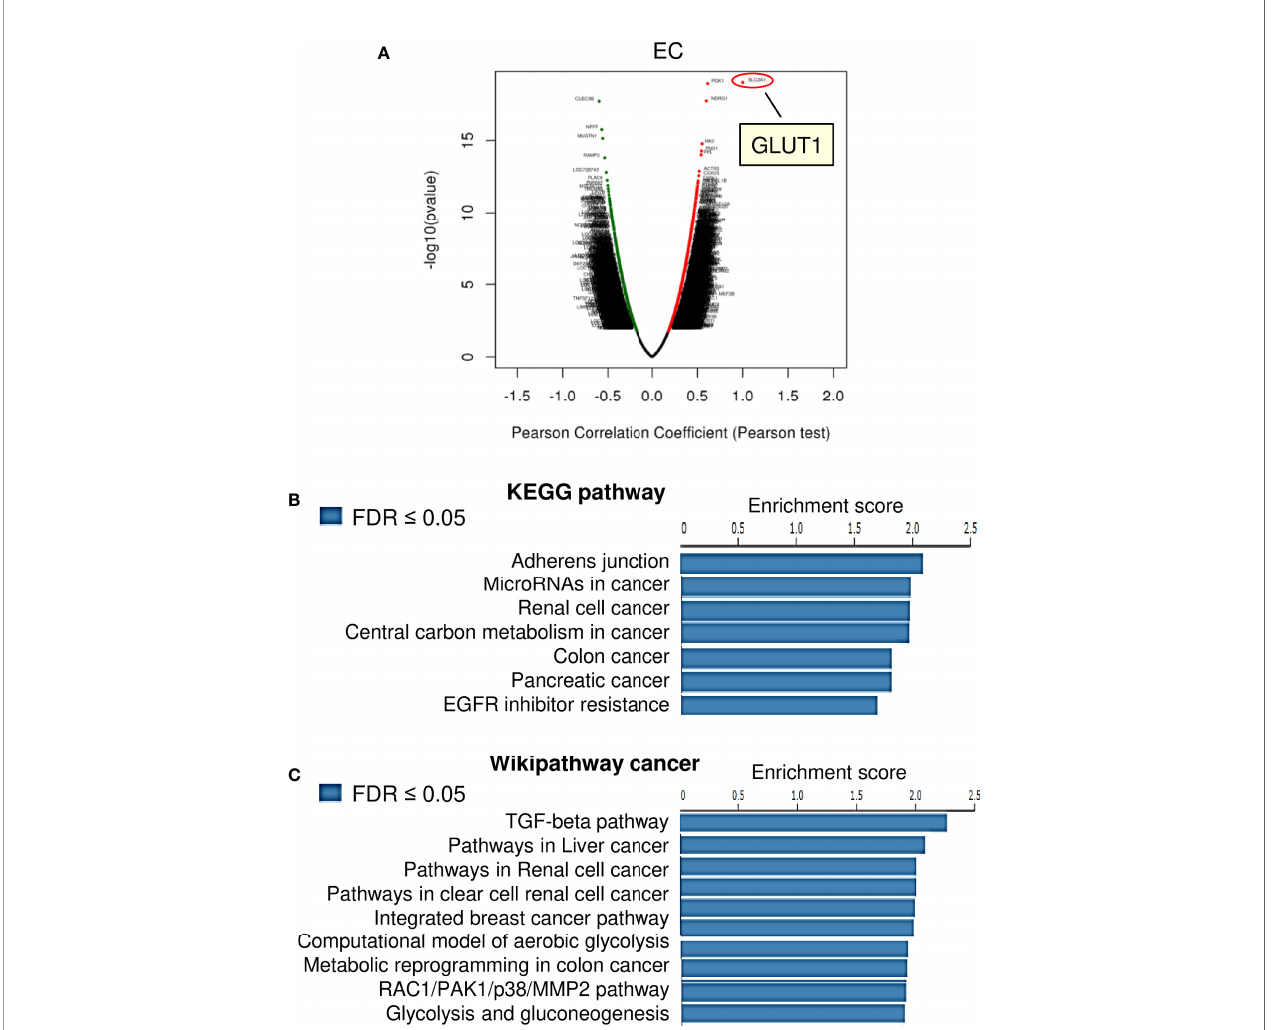
FIGURE 3 | KEGG Pathway and Wiki Pathway Enrichment Analysis of GLUT1 -Associated Genes in EC. (A) Genes that were found to be highly co-expressed with GLUT1 in the TCGA EC dataset from the LinkedOmics database were chosen. (B, C) Gene set enrichment analysis for positively correlated genes of GLUT1 in TCGA EC tissues. Enrichment analysis for KEGG pathways (B) and Wikipathway cancer (C) was performed using the LinkedOmics